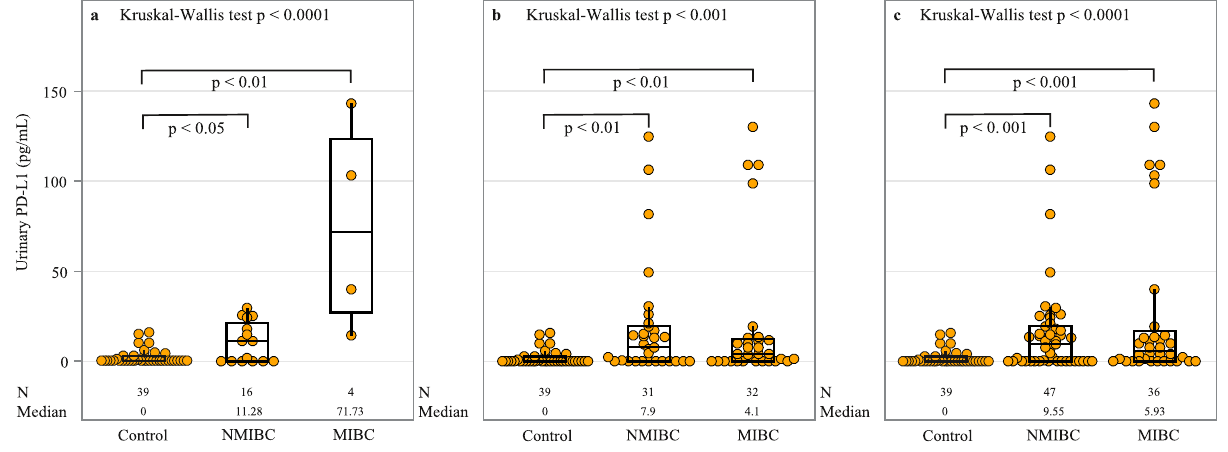
Figure 1. Distribution of PD-L1 concentration in controls and NMIBC and MIBC sub-groups. Patients with BCa are sampled from: ( a ) group 1 (before TURB), ( b ) group 2 (after TURB) and ( c ) combined groups 1 and 2. Results are presented by a box plot, with each dot representing one patient. An extreme outlier of 487.5 pg/ mL in the MIBC sub-group in ( b ) and ( c ) is not shown on the plot. Analysis of urinary PD-L1 concentrations demonstrated departure from Gaussian distribution using Shapiro–Wilk test in all groups. Non-parametric Kruskal–Wallis test was thus used to determine if there was significant variation in the medians of the groups analyzed. If significant at the 5% level, we then used Dunn’s multiple comparison post-hoc test to investigate pair-wise group comparisons of urinary PD-L1. This testing procedure was followed in ( a–c ). Only significant comparisons as follows from Dunn’s post-hoc test are shown. Abbreviations: BCa: bladder cancer; N: number of observations; NMIBC: non-muscle invasive bladder cancer; MIBC: muscle-invasive bladder cancer; PD-L1: programmed death ligand-1; TURB: transurethral resection of the bladder.